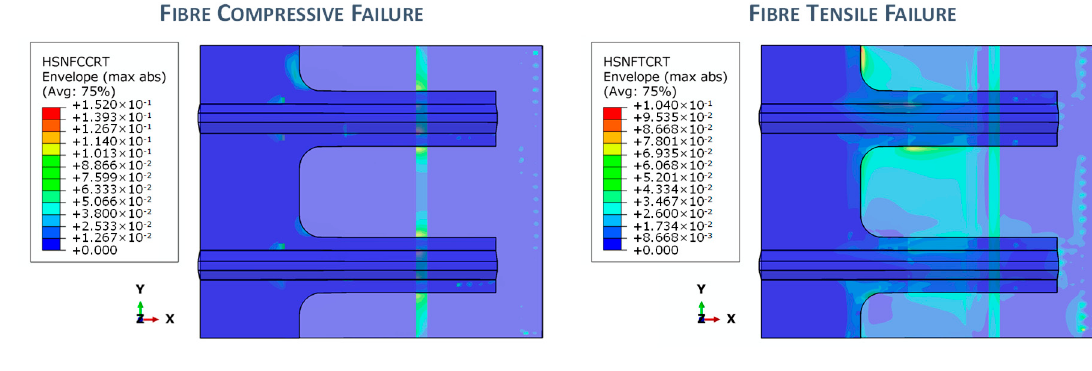
Figure 21. Hashin’s failure criteria: fibre.